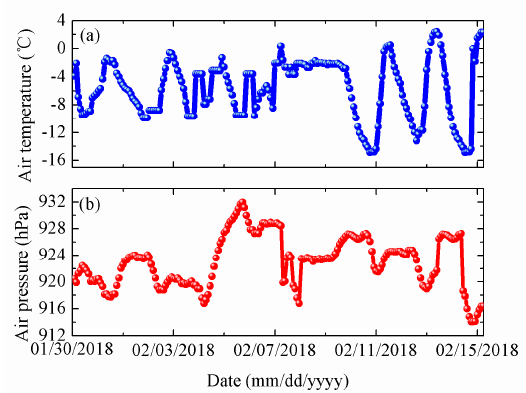
Figure 19. Air temperature ( a ) and air pressure ( b ) from 30 January to 15 February.